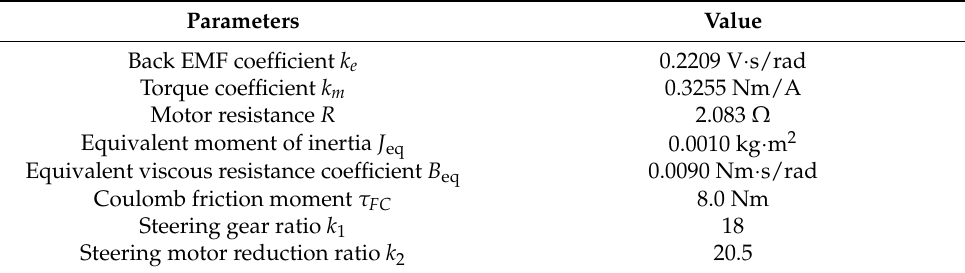
Figure 3. Experimental platform of the SBW system. Table 1. SBW system